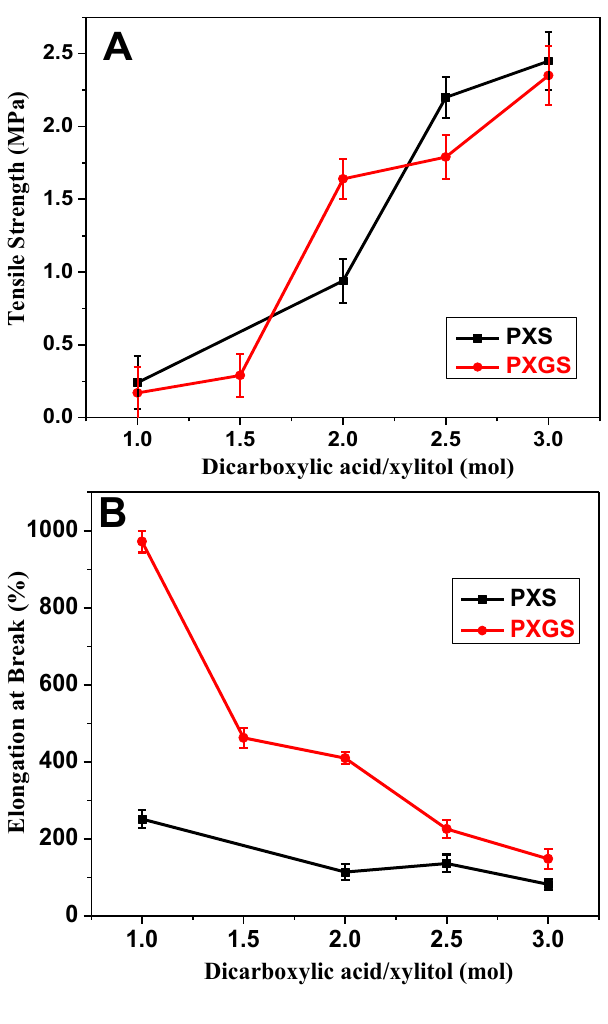
Figure 6. The tensile strength ( A ) and elongation at break ( B ) of PXS and PXGS are as a function of the ratios of dicarboxylic